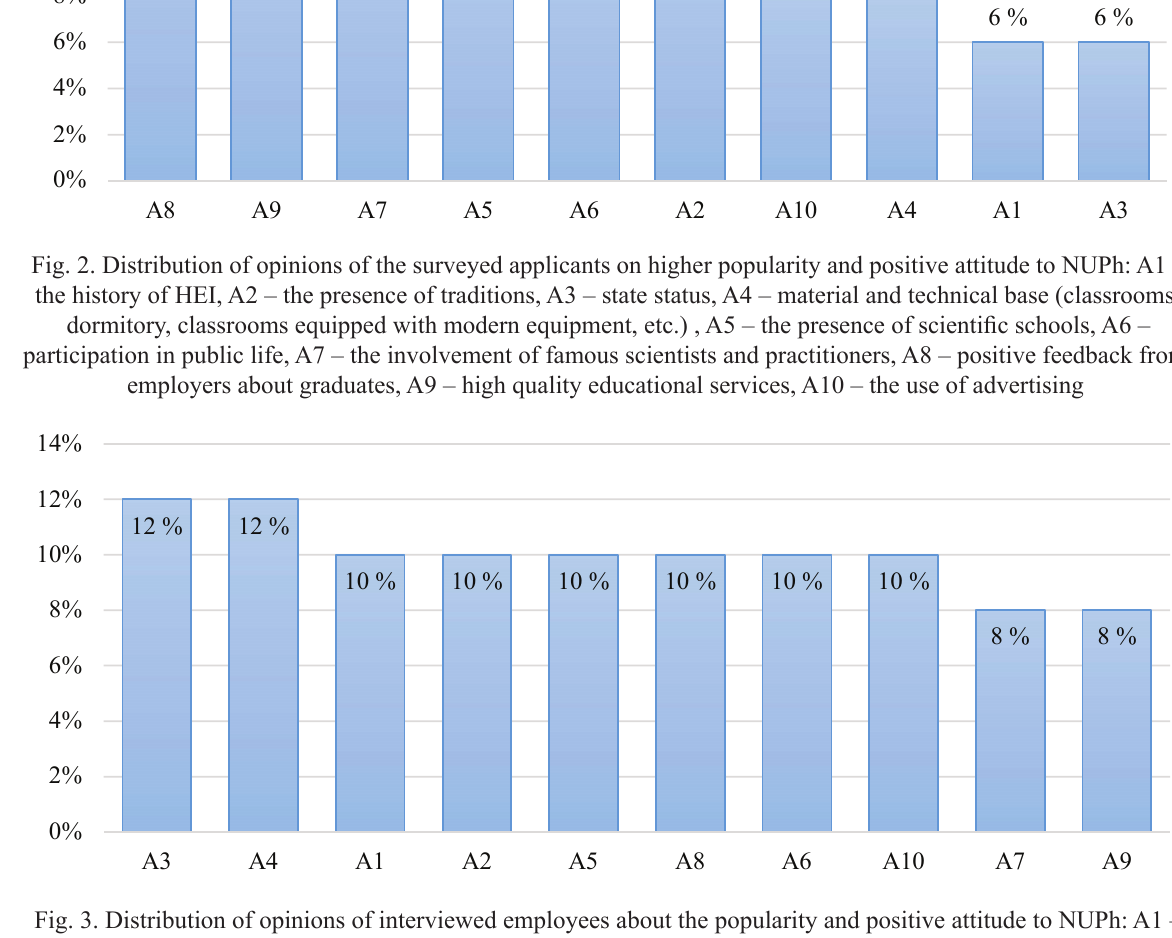
Fig. 3. Distribution of opinions of interviewed employees about the popularity and positive attitude to NUPh: A1